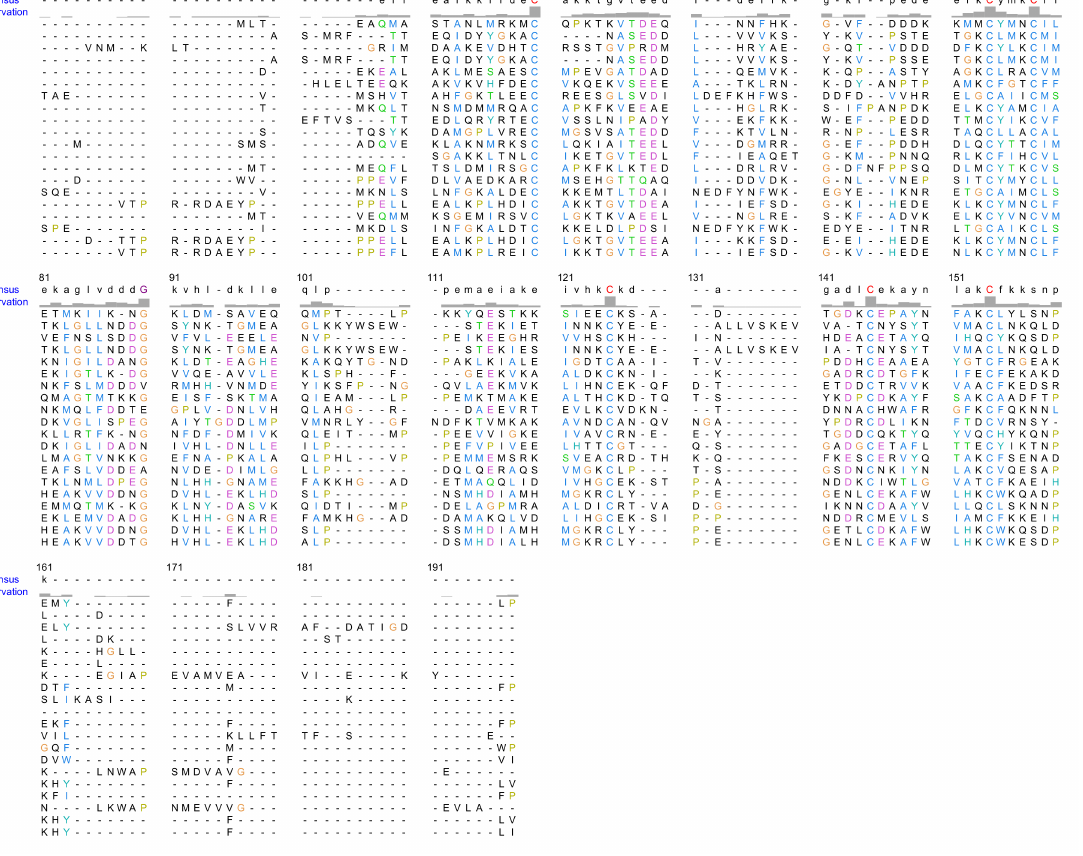
Figure A1. Structural alignment of